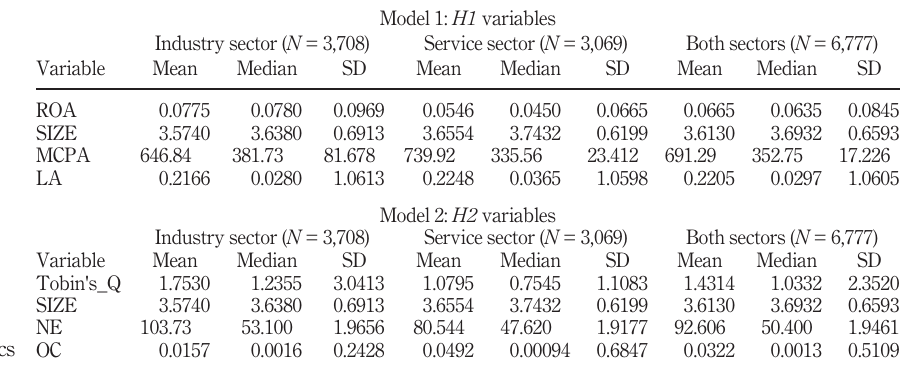
Table II. Descriptive